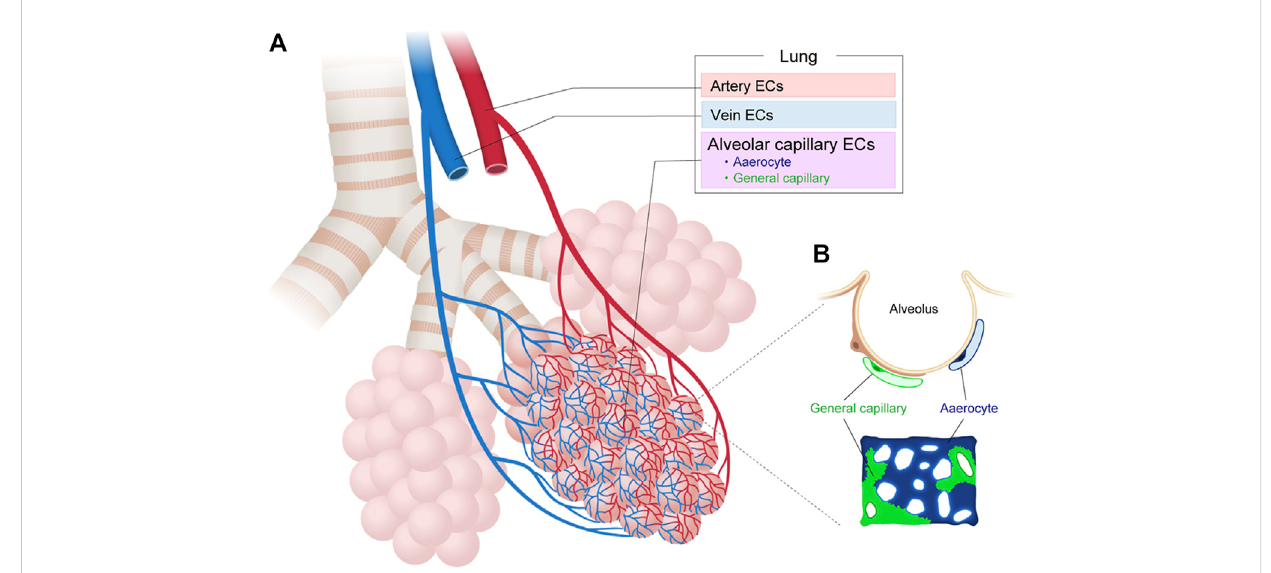
FIGURE 3 Vascular endothelialcell heterogeneity inthe lung. (A) Vascular endothelial cells (ECs) inthe lung can beclassi fi edinto artery, vein,and capillaryECs based on their structure and molecular differences. (B) Alveolar capillary ECs are further classi fi ed into aerocytes and general capillary ECs.